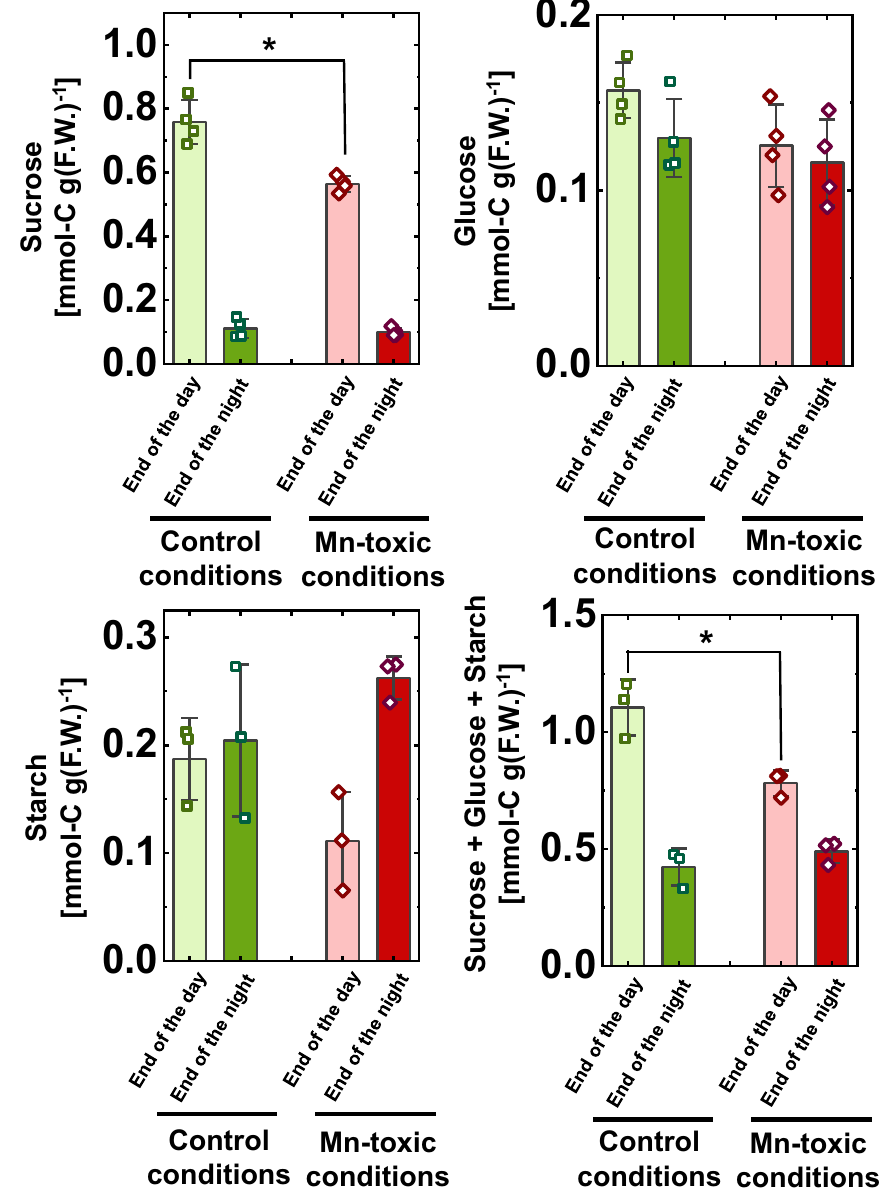
Figure 4. Carbohydrate content in leaf blades at the end of the day and end of the night. Data are shown as means with standard deviation (SD) obtained from independent biological replicates (n = 3–4), and squares and diamonds show the distribution of the raw data. Asterisks show significant differences between the control and Mn-toxic conditions (* p < 0.05, Kruskal–Wallis